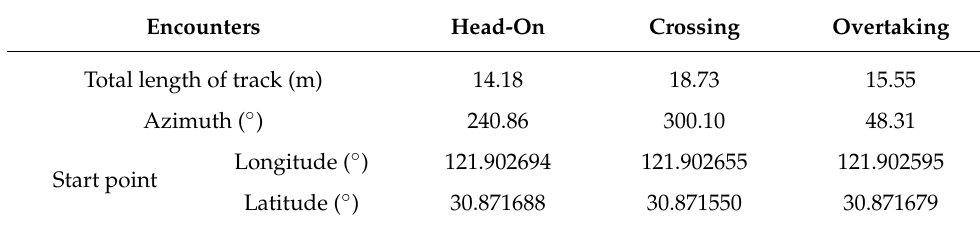
Table 9. Dynamic obstacle trajectory